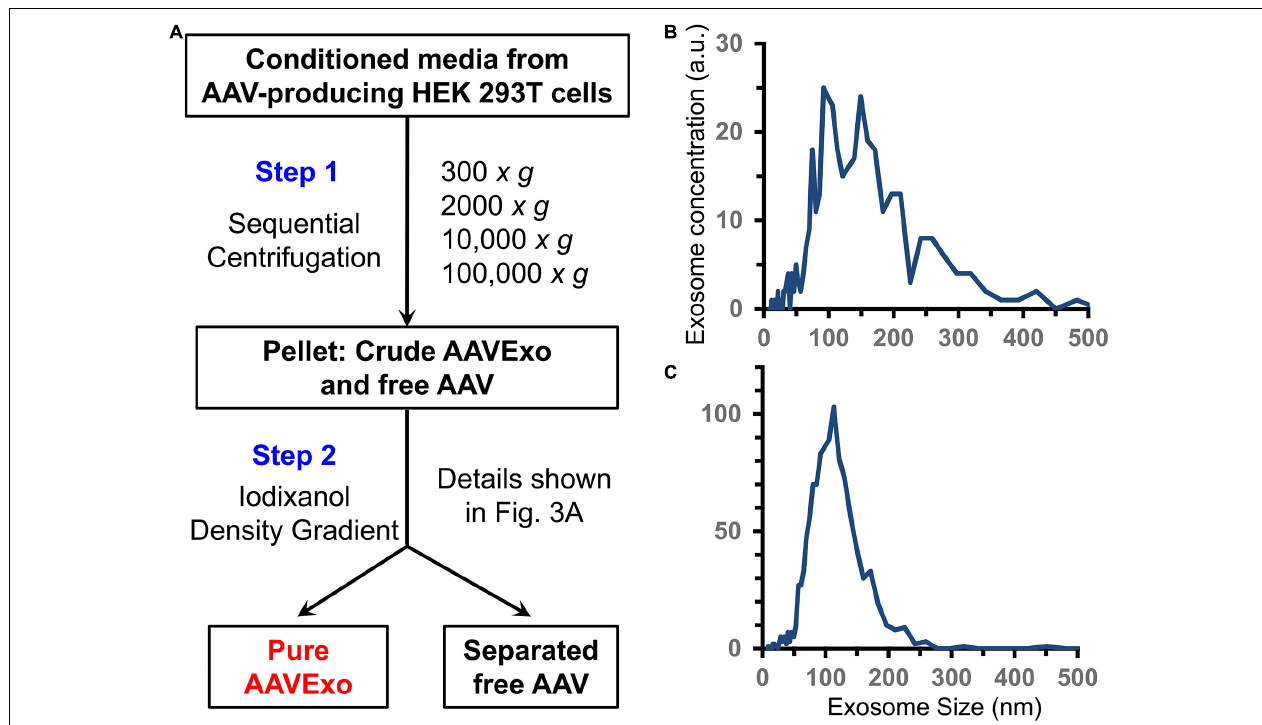
FIGURE 1 | Exosomes are secreted and isolated from the conditioned medium of AAV-transfected HEK 293T cells. (A) Methodology flow chart of 2-step AAVExo purification. (B) Conditioned medium of AAV-producing HEK 293T cells analyzed by ZetaView. Five biological replicates were performed, and a representative was shown. (C) Purified AAVExo analyzed by ZetaView. Three biological replicates were performed, and a representative was shown here.